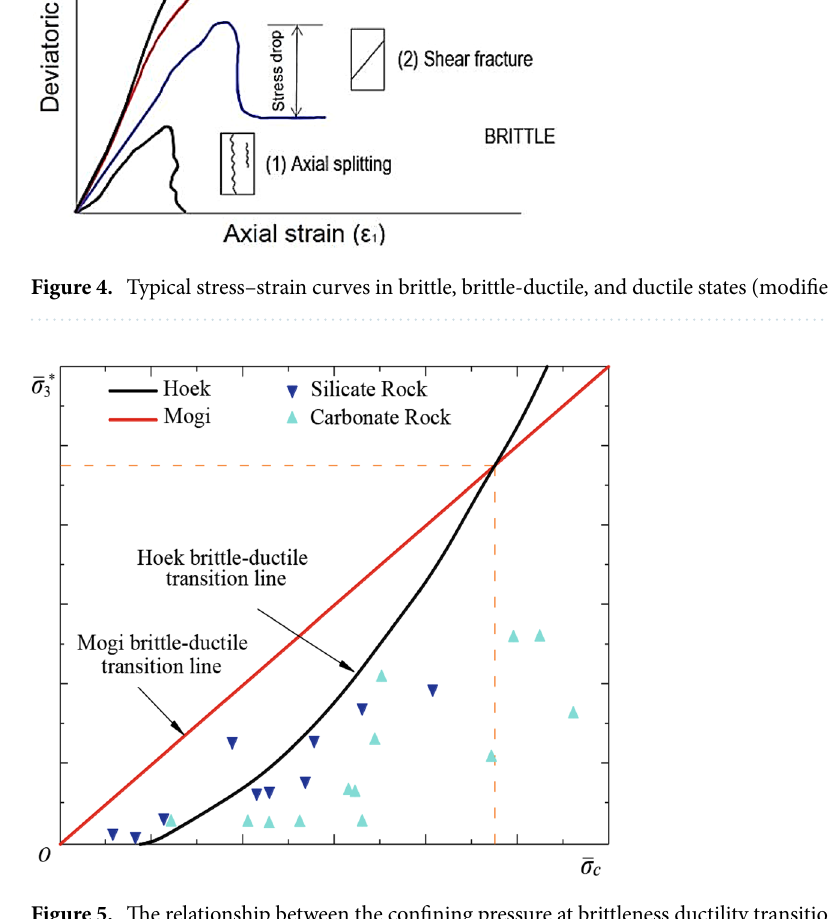
Figure 5. The relationship between the confining pressure at brittleness ductility transition and the value of UCS 48